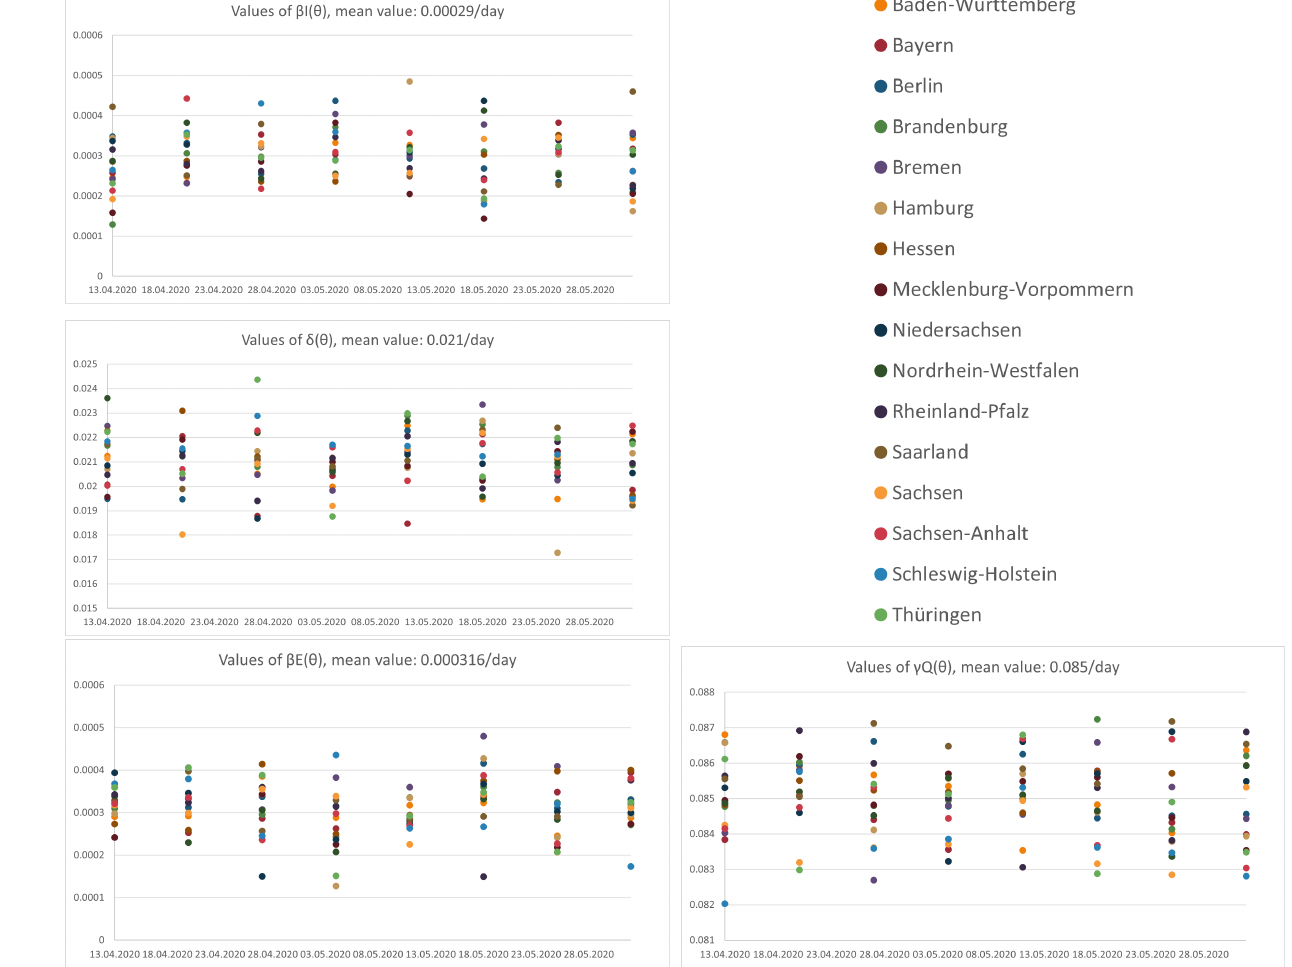
Figure 7. Values of γ Q p θ q , β E , I p θ q , δ p θ q with different time period fitting for the respective federal